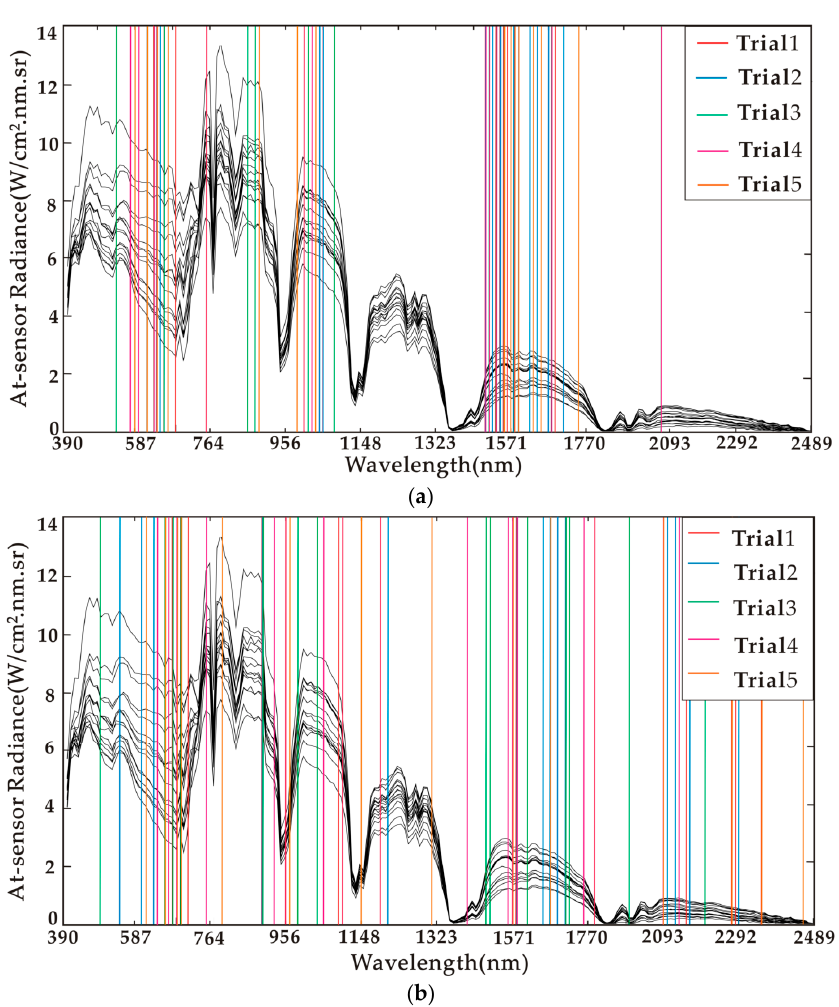
Figure 5. Wavelength of selected bands (straight lines) compared to the radiance value at the sensor for each land cover class (16 curves) for the: ( a ) FM-AP; and ( b ) proposed DFM-AP (Indian Pines dataset).